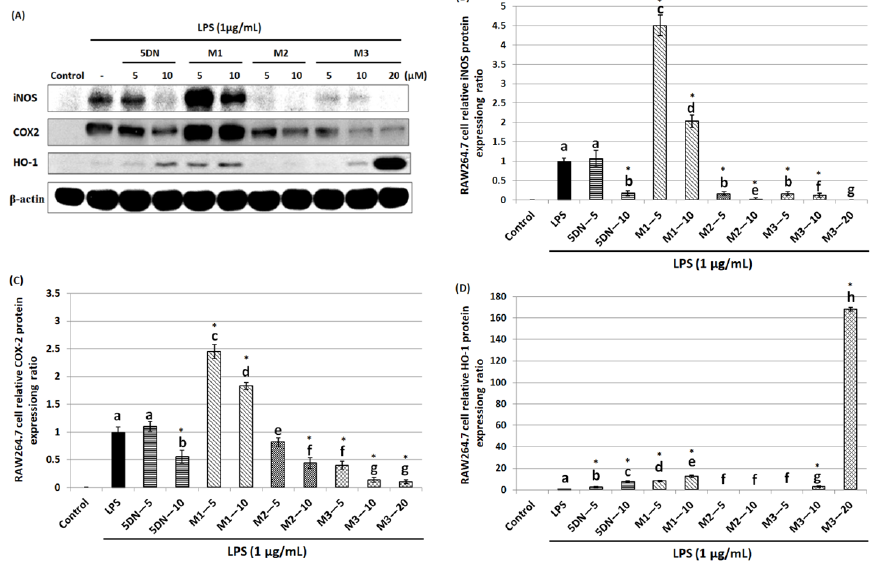
Figure 2. Effects of 5DN and its metabolites M1, M2, and M3 on the protein levels of iNOS ( A , B ), COX-2 ( A , C ), and HO-1 ( A , D ) in LPS-stimulated RAW 264.7 macrophages. The numbers underneath the blots represent band intensity (normalized to β -actin, means of three independent experiments) measured by Image J software. The standard deviations (all within ± 15% of the means) were not shown. β -actin was served as an equal loading control. Different superscript letters in each column indicate significant differences between groups ( p < 0.05, n = 3) by one-way ANOVA and Tukey’s post hoc test. “*” indicates statistical significance compared to the control ( p < 0.05, n = 3).